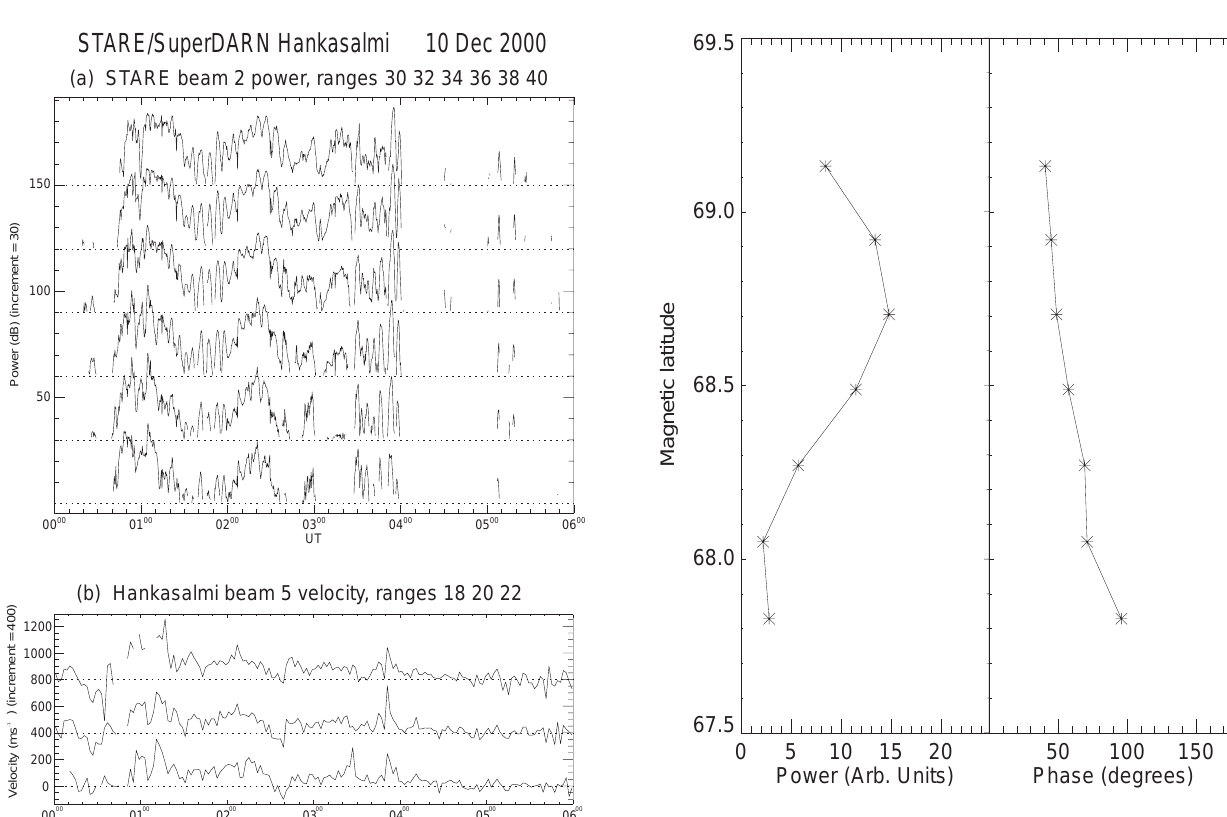
Fig. 19. Amplitude and phase of the 2.7mHz spectral component observed by the STARE Norway radar beam 2 in range gates 28, 30, 32, 34, 36, 38, 40, in the interval 01:30–02:00UT on 10 December